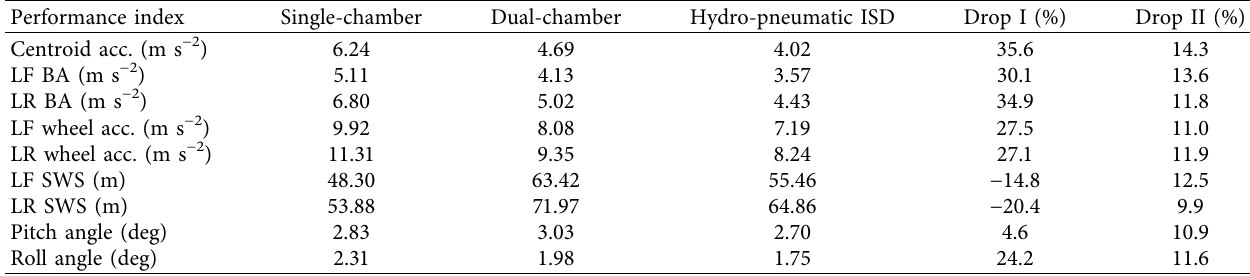
Table 5: PTP values of pulse input response for test.